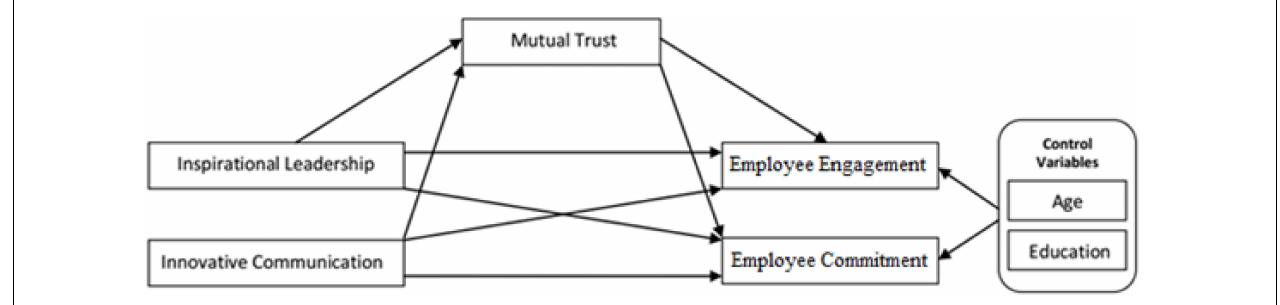
FIGURE 1 | Conceptual